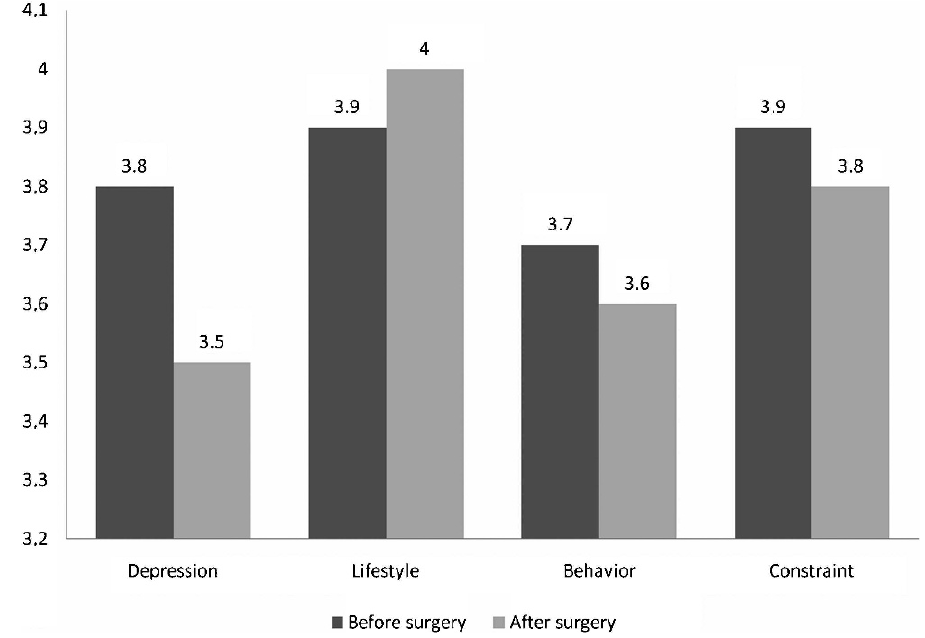
Figure 2 - Comparative analyses of Fecal Incontinence Quality of Life Scores before and after perineal prostatectomy.